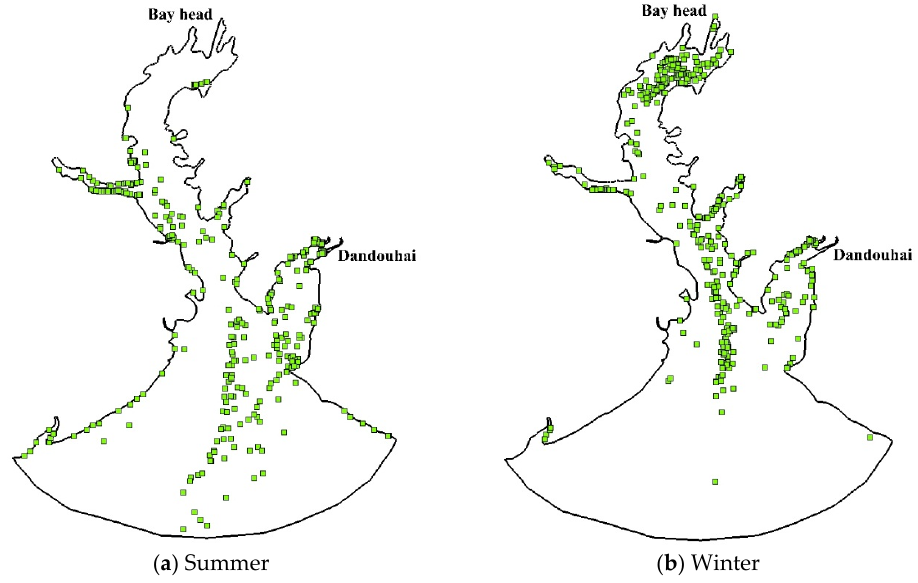
Figure 12. Particle distribution after 92-day simulation ( a ) in summer; ( b ) in winter (2008). The transport trajectories simulation shows that the particles released from the bay head remain in the bay head, indicating that this area is a slow flushing zone, which inhibits the diffusion of pollutants. Although the particles released from Shitoubu also remain in the bay after a 30-day diffusion in this area (Figure 11h). When the particles are released from the west trough, the tidal north side of the bay with the flood current, and then move to the south side of the bay with the ebb